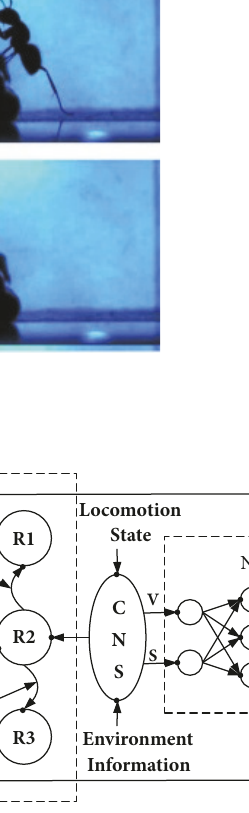
Figure 11: Schematic diagram of the model